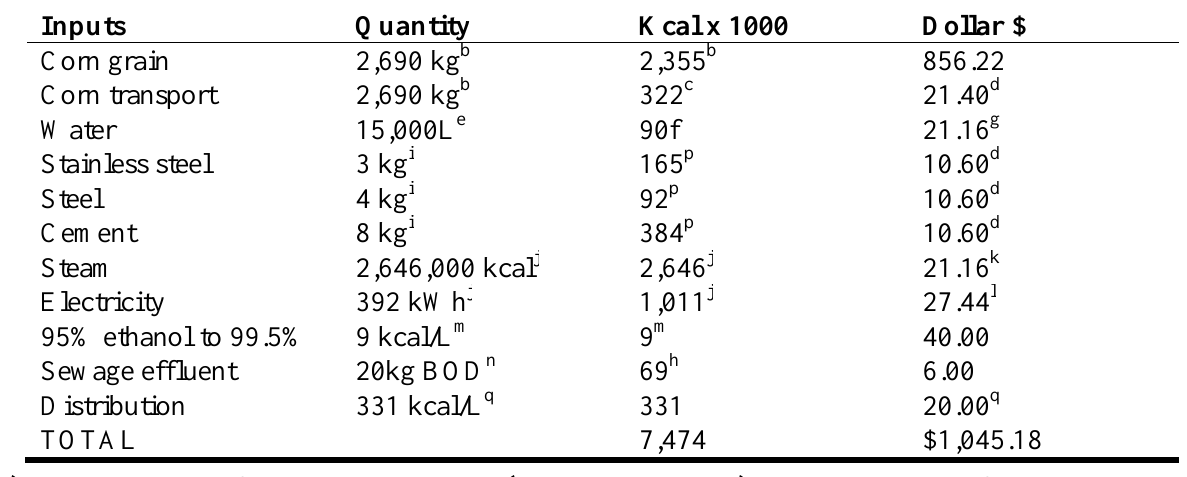
Table 5. Inputs per 1000 liters of 99.5% ethanol produced from corn.